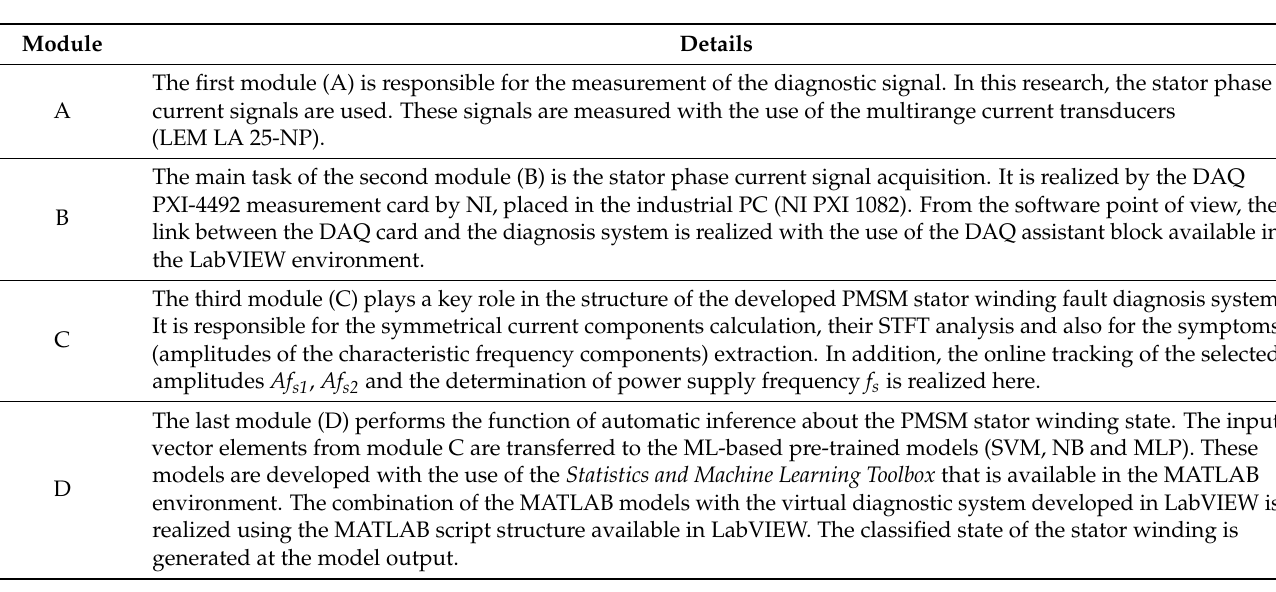
Figure 25. ( a ) Part of the stator phase current negative sequence component STFT spectrogram and ( b ) response of the NB-based ITSC fault classifier.